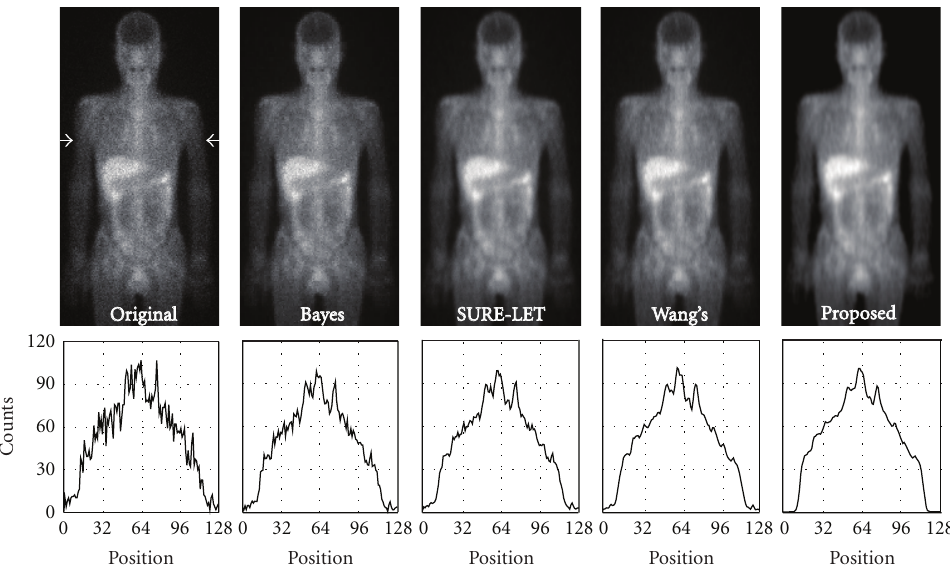
Figure 6: Results of the simulations with a 67 Ga-scintigram. From left to right: an original scintigram, BayesShrink, SURE-LET, Wang’s method, and our proposed method. The profile along a line indicated with two arrows is shown below each